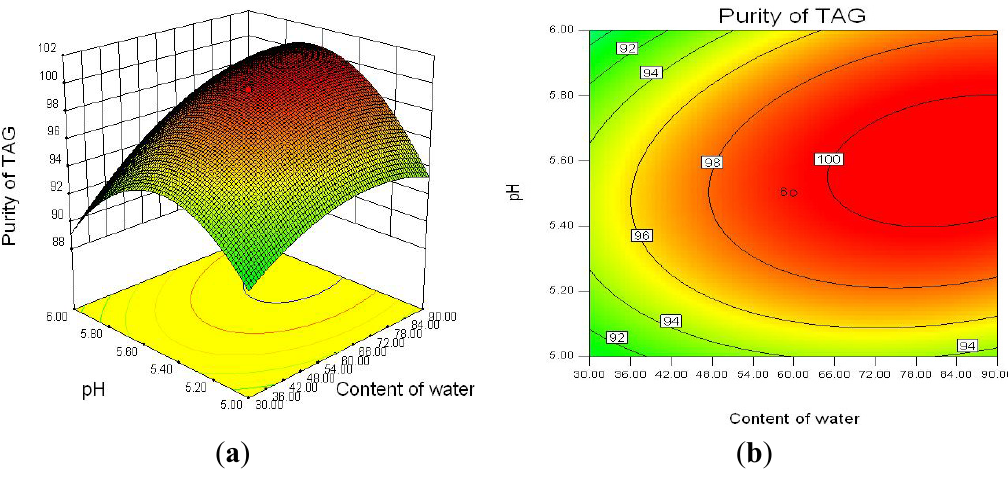
Figure 4. Response surface plot ( a ) and its contour plot ( b ) of the TAG purity; pH vs. water content with a constant level of temperature (20 °C).